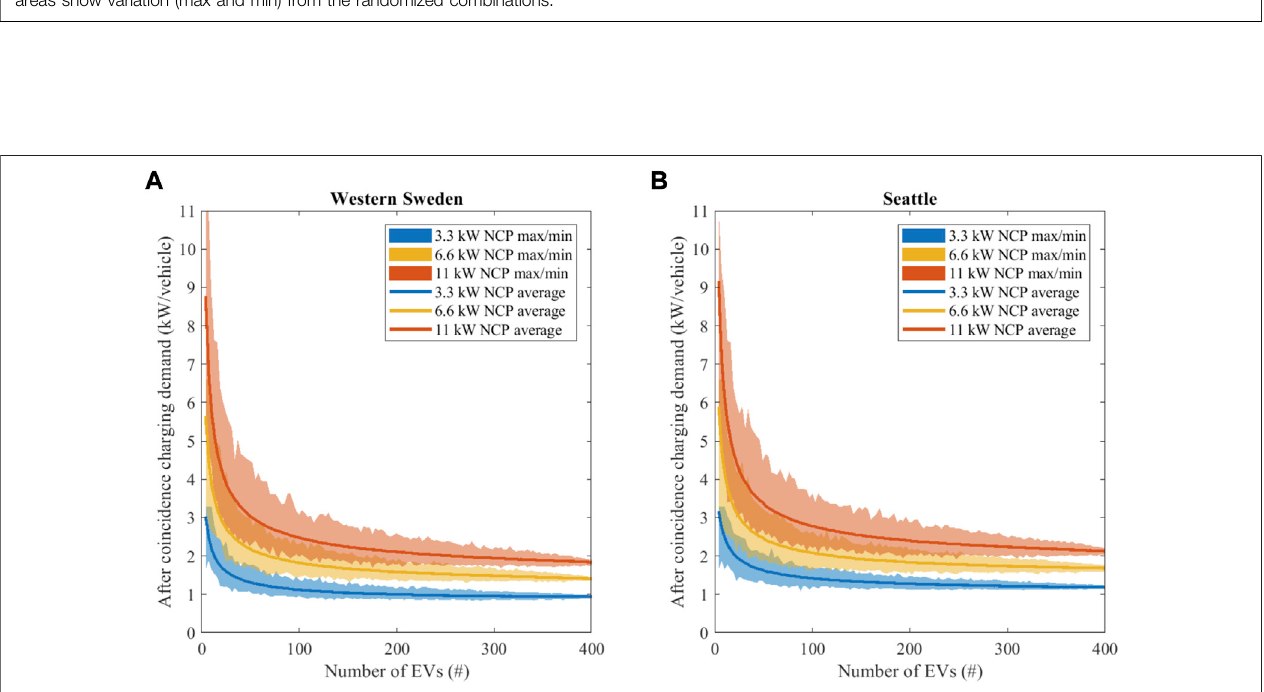
FIGURE 3 | After-coincidence charging power demand for the highest hour of the year and as an average for all combination of vehicles with different driving patterns.After-coincidencechargingpowerdemandforthreedifferentNominalChargingPowers(NCP).Charginglocationishomeonlyandelectricitydemandperkmis assumed to be 0.20 kWh/km. Data for Western Sweden in (A) and Seattle (B) . Shaded areas show variation (max and min) from the randomized combinations.